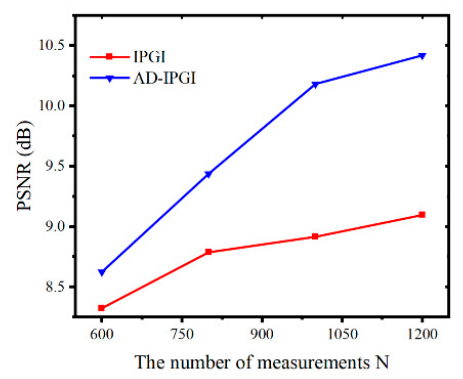
Figure 5. The PSNR curves of the image “Zhong”.